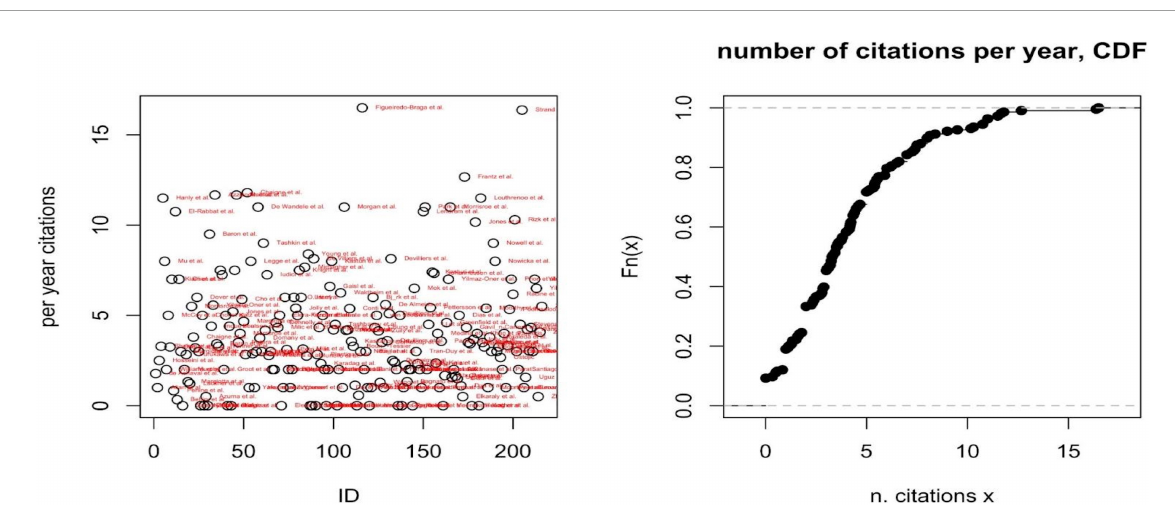
FIGURE3 Per year number of citations (left) and cumulative distribution function (CDF) of the number of citations per year